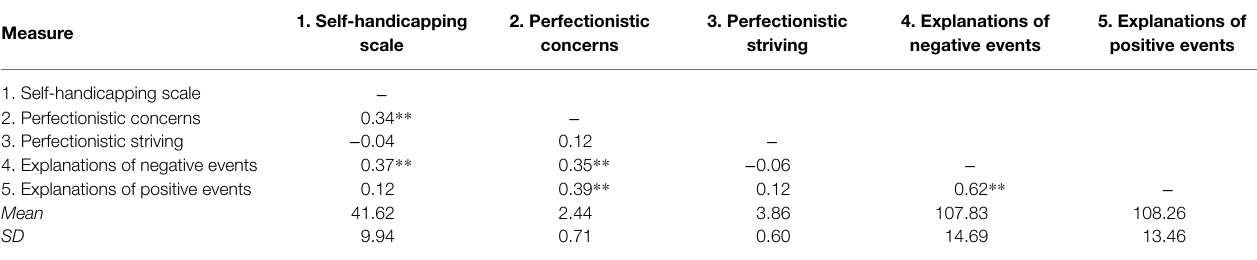
TABLE 1 | Means , SDs , and zero-order correlations ( N = 111). Measure